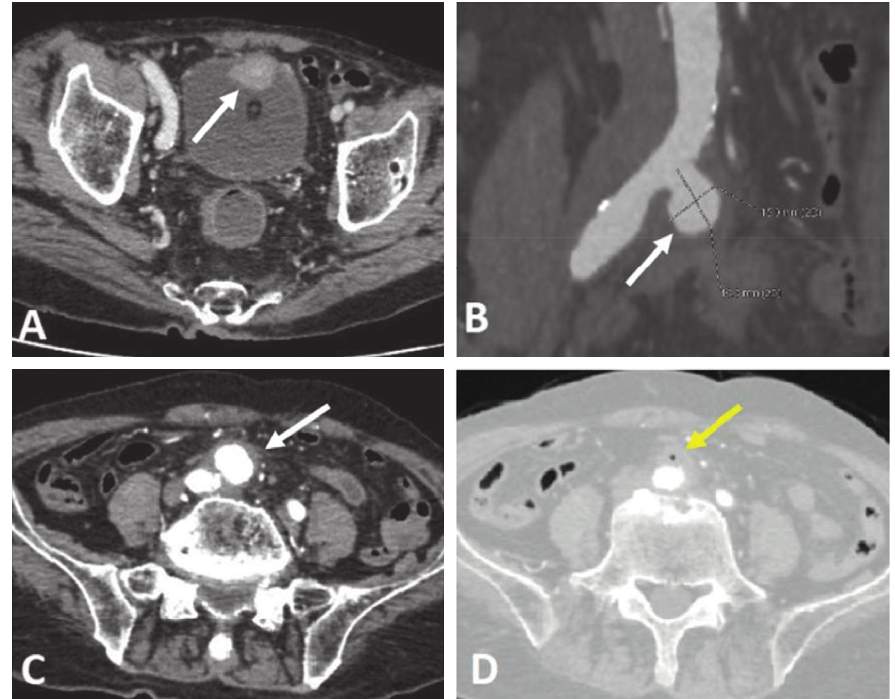
Figure 1: CTscanner forty days prior to admission. (a) Enhanced axial CTshows a bladder tumor (arrow). (b, c) Enhanced coronal and axial CTshows a 17 × 18mm saccular aneurysm arising from the right common iliac artery (arrows) surrounded by fat stranding. (d) Enhanced axial CT shows small foci of gas